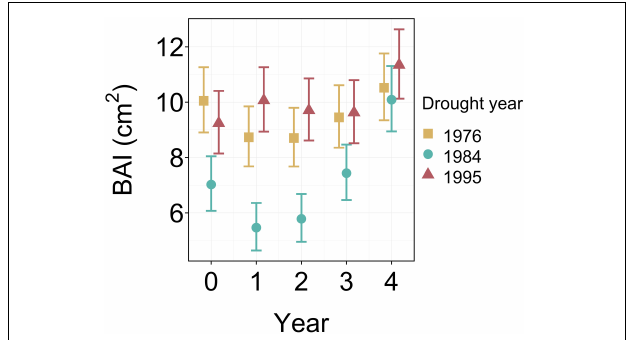
FIGURE 3 | BAI adjusted marginal means (averaged over high ( ρ H ) and low ( ρ L ) density stands) for the 1976, 1984, and 1995 drought years. Year = 0 represents the drought year while years 1–4 indicate the 4 years post-drought, while error bars represent 95% unadjusted confidence intervals.